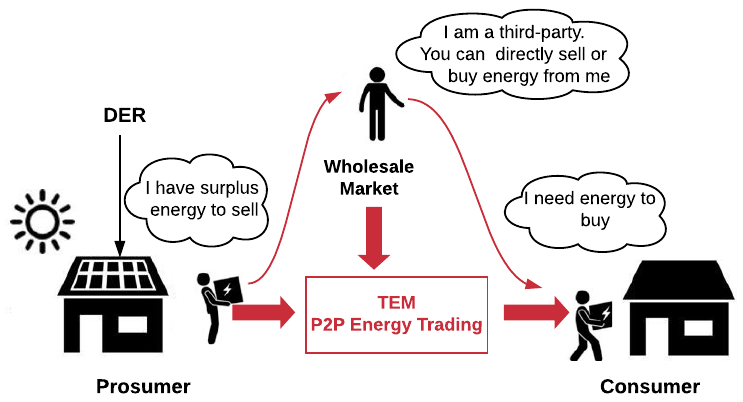
Figure 1. Energy trading process in a